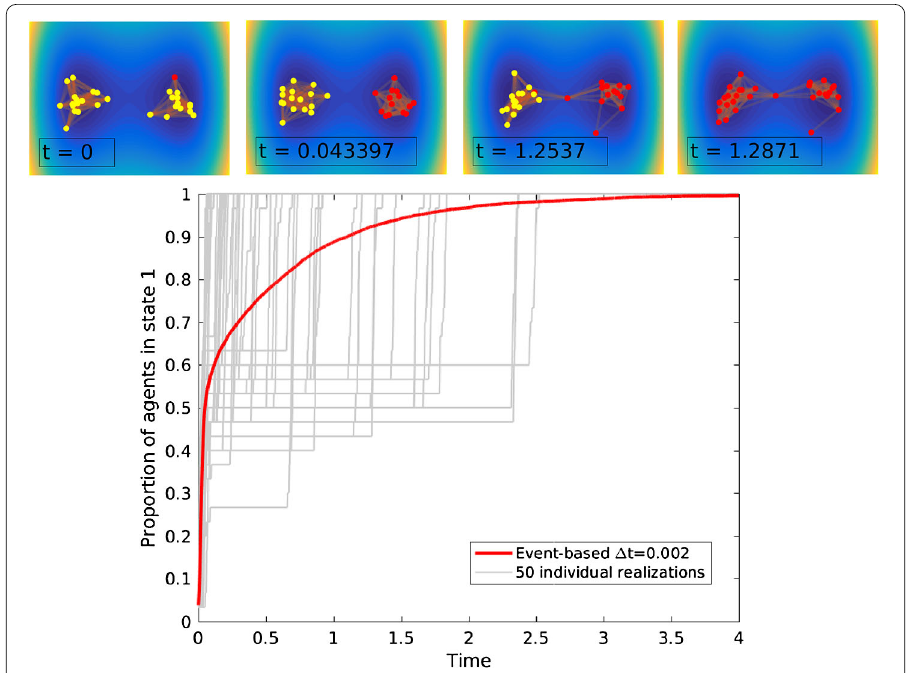
Figure 4 We are considering a model example with n = 30 agents, where the suitability landscape is given by the double well potential V ( x , y ) = ( x 2 – 1) 2 + y 2 and the interaction radius is r = 1. In the first row, temporal snapshots of one realization of the process highlight its metastability. Due to the fast mixing in the well of the initial adopter, the innovation spreads quickly in the first well. In contrast, the transitioning between the two wells is a rare event, resulting in a large time gap for the innovation to spread from one well to the other. Then again, when the innovation has reached the second well, it will spread fast. The metastability of the spreading process is also confirmed in the plot of the evolution of the proportion of adopters. The 50 realizations (plotted in gray) out of an ensemble of 2000 simulations with the event-based approach for (cid:7) t = 0.002 show the fast spreading inside the wells and the exponential waiting time for the innovation to jump from one well to